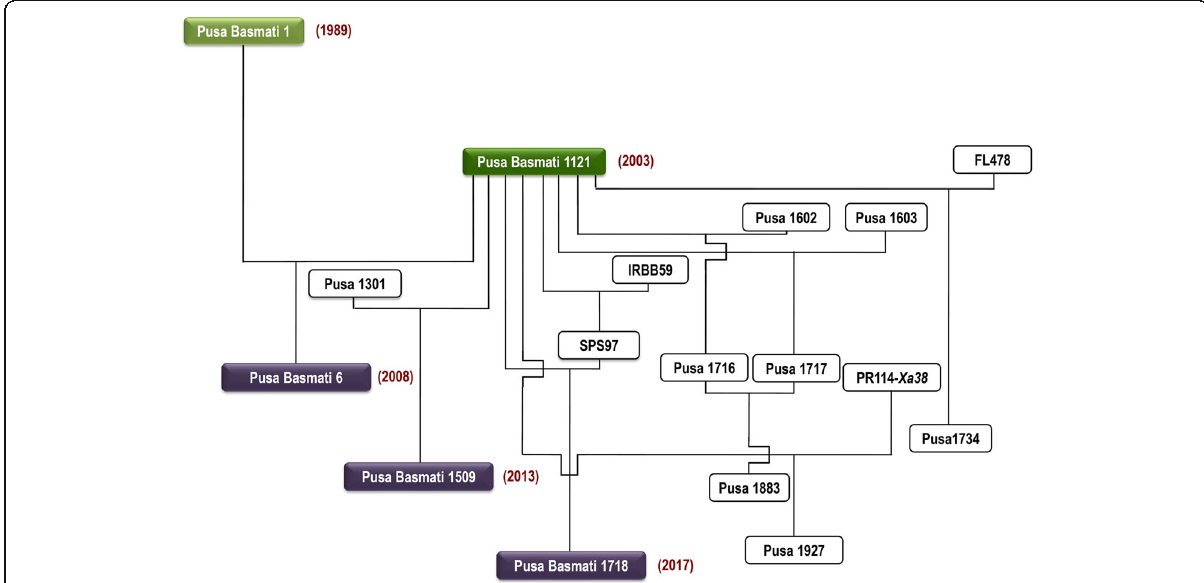
Fig. 10 Important Basmati rice varieties and improved Basmati rice genotypes derived from PB